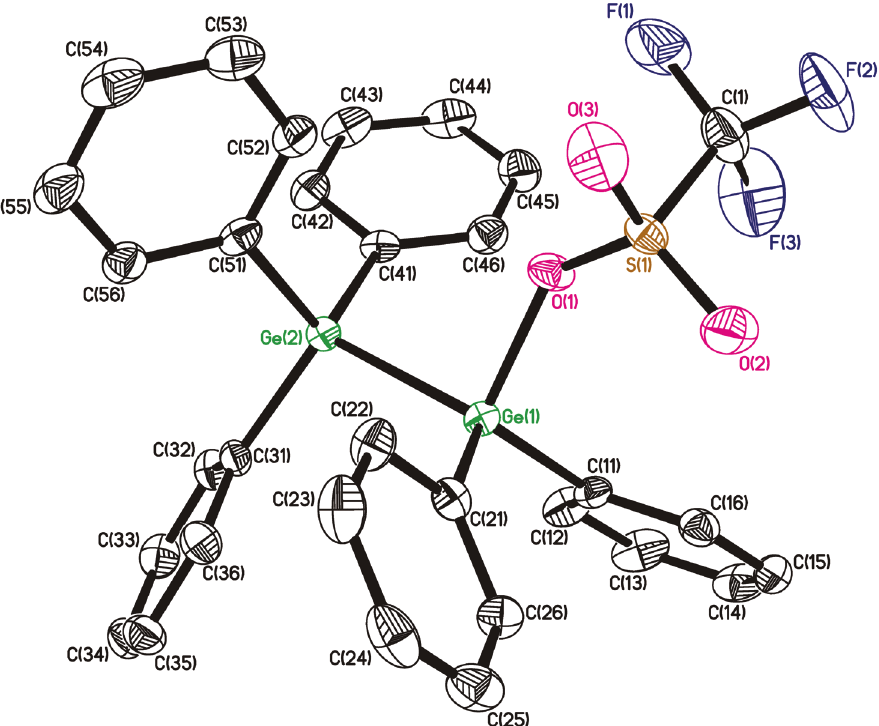
Figure 1 Molecular structure of compound 5 . Displacement ellipsoids are drawn at 50% probability level. Hydrogen atoms are omitted for clarity. Selected bond lengths (Å) and angles ( ° ): Ge(1)-Ge(2) 2.4181(4), Ge(1)-O(1) 1.9169(19), Ge(1)-C(11) 1.928(3), Ge(1)-C(21) 1.925(3), Ge(2)-C(31) 1.948(3), Ge(2)-C(41) 1.944(3), Ge(2)-C(51) 1.955(3); O(1)-Ge(1)-C(21) 103.12(10), O(1)-Ge(1)-C(11) 105.66(10), C(21)-Ge(1)-C(11) 113.74(11), O(1)-Ge(1)-Ge(2) 94.68(6), C(21)- Ge(1)-Ge(2) 116.82(8), C(11)-Ge(1)-Ge(2) 118.56(8), C(41)-Ge(2)-C(31) 114.80(12), C(41)-Ge(2)-C(51) 110.13(11), C(31)-Ge(2)-C(51) 111.88(12), C(41)-Ge(2)-Ge(1) 109.42(8), C(31)-Ge(2)-Ge(1) 104.78(8), C(51)-Ge(2)-Ge(1)